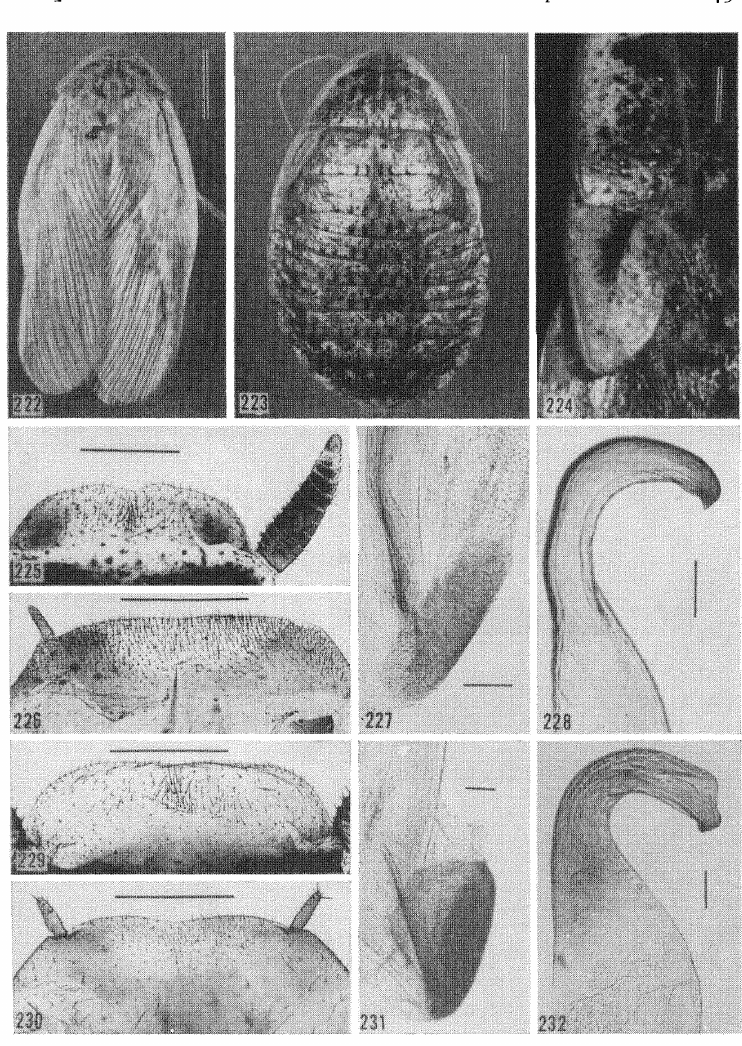
Figures 222-232. Calolampra atomi[era. 222. (64 BMNH), holotype, Nova Hollandia (without exact locality). 223. 9 (65 BMNH), lectotype of Polyzosteria propria Walker, S. A. (without exact locality). 224. Tegmen of female shown in figure 223. 225-228. Supra-anal plate, hypandrium, and genitalia o.f holotype shown in figure 222. 229-232. / (7 SAM), Ade- laide, S. A. Supra-anal plate, hypandrium, and genitalia. Scale: Figs. 222- 223 4 mm; Figs. 224, 225-226, 229-230 ram; Figs. 227-228, 231-